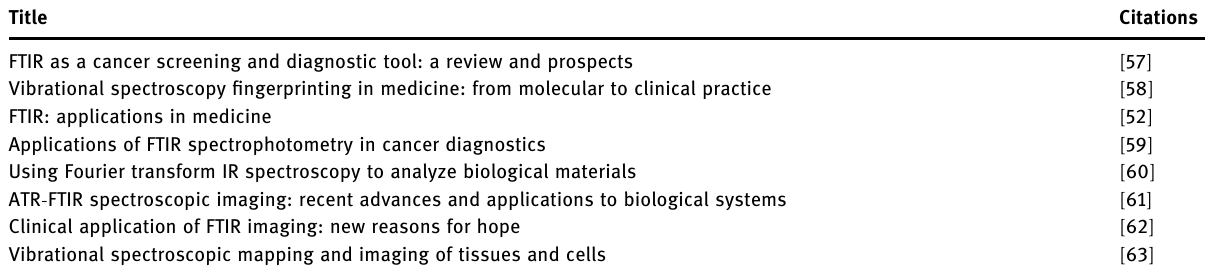
Table 3: Selected publications on the medical diagnostic capability of vibrational FTIR